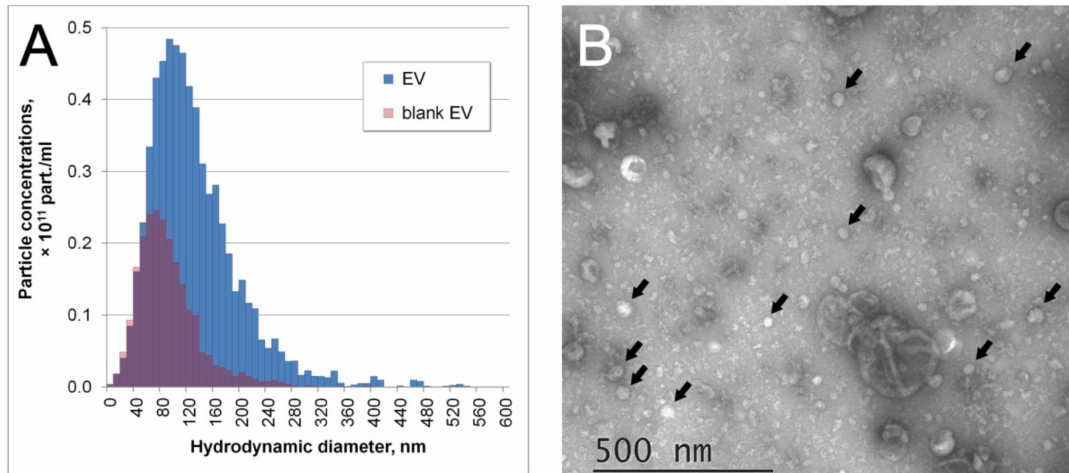
Figure 3. Characteristics of the extracellular vesicle (EV) preparations from conditioned medium after 24 h of MSC cultivation. ( A ) Particle size distributions of EV preparation and resuspended pellet from nonconditioned culture medium passed through all centrifugations (blank EV). ( B ) Transmission electron microscopy image of EV preparation. Arrows mark several smaller particles of nonvesicular